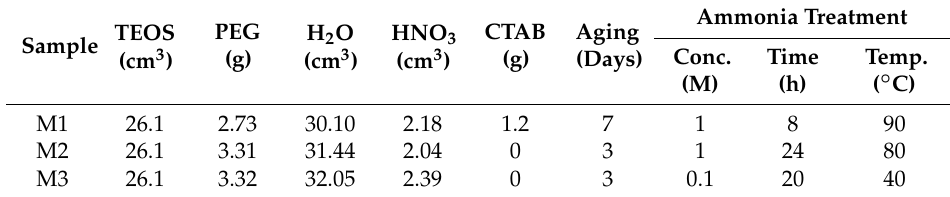
Table 5. Composition of reagents for monolith synthesis and conditions during ammonia aqueous solution treatment of monoliths prior to drying. PEG: polyethylene